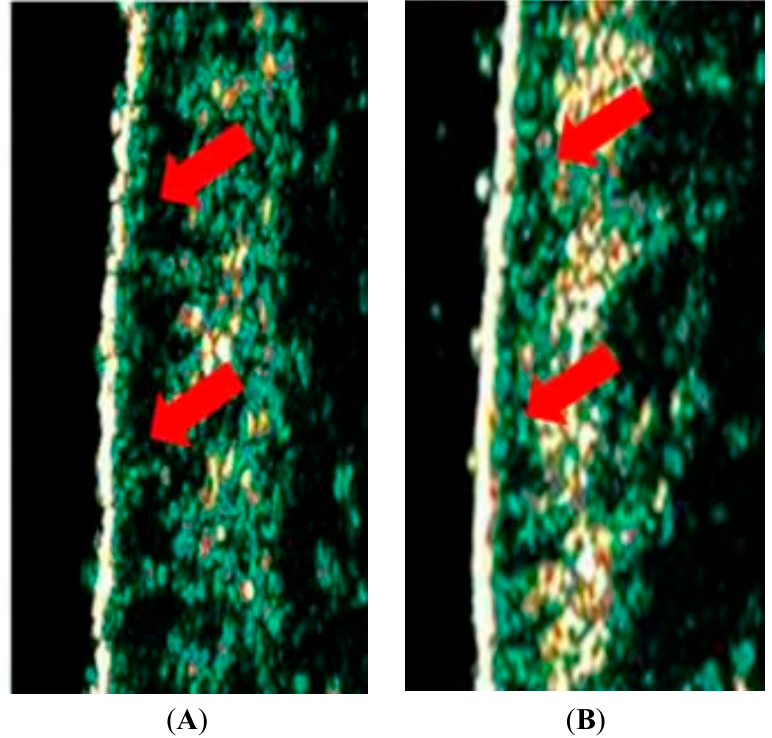
Figura 5. Illustrative images obtained on the face with the 20 MHz ultrasound of an elderly volunteer ( A ) and of a younger volunteer ( B ), highlighted hypoechogenic bands.